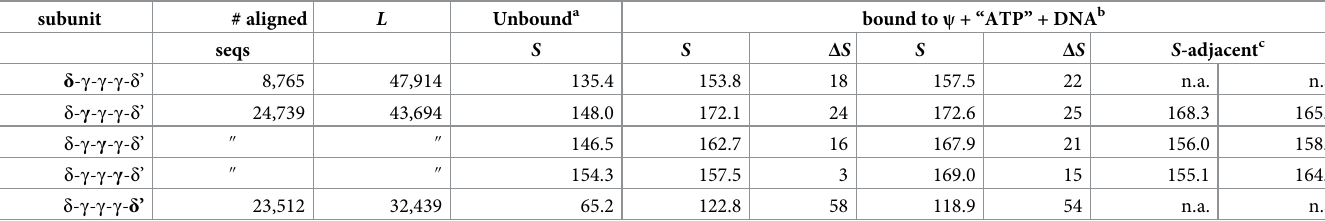
Table 7. S as a measure of structural biological relevance for the bacterial DNA clamp loader complex based on a maximum distance of 2.6 Å . subunit